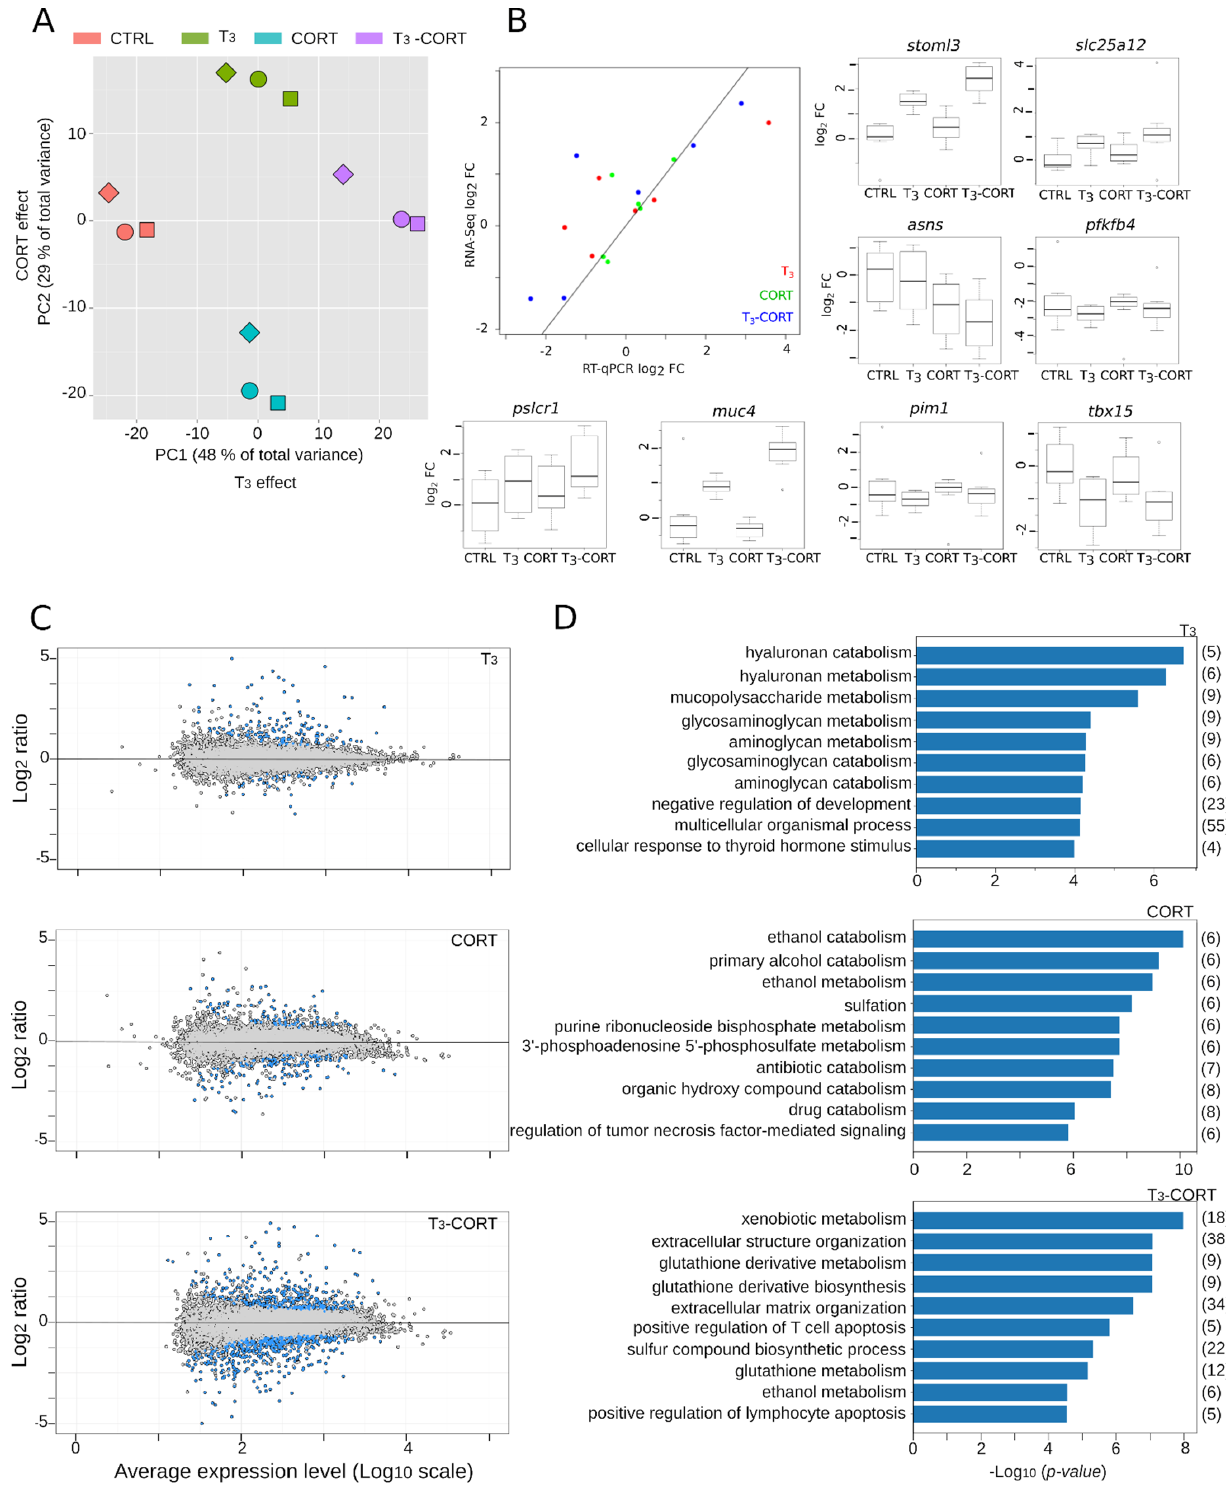
Figure 2. Transcriptome analysis following T 3 and/or CORT. ( A ) Principal Component Analysis (PCA) of RNA-Seq variance from tailfin dissected from cultured tail explants. The two main components capture the effects of both hormones, corresponding to 77% of the total variance. Square, circle, and diamond: biological replicates. ( B ) Independent validation of RNA-Seq data by RT-qPCR. Scatter plot of the relationship between RNA-Seq versus RT-qPCR expression changes, also shown in box plots. ( C ) Average expression value versus fold change (MA plot). DE genes are in blue. ( D ) Gene Ontology